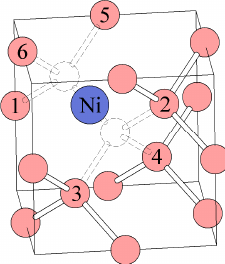
Figure 1. The diamond unit cell with a nickel atom at a split-vacancy site.